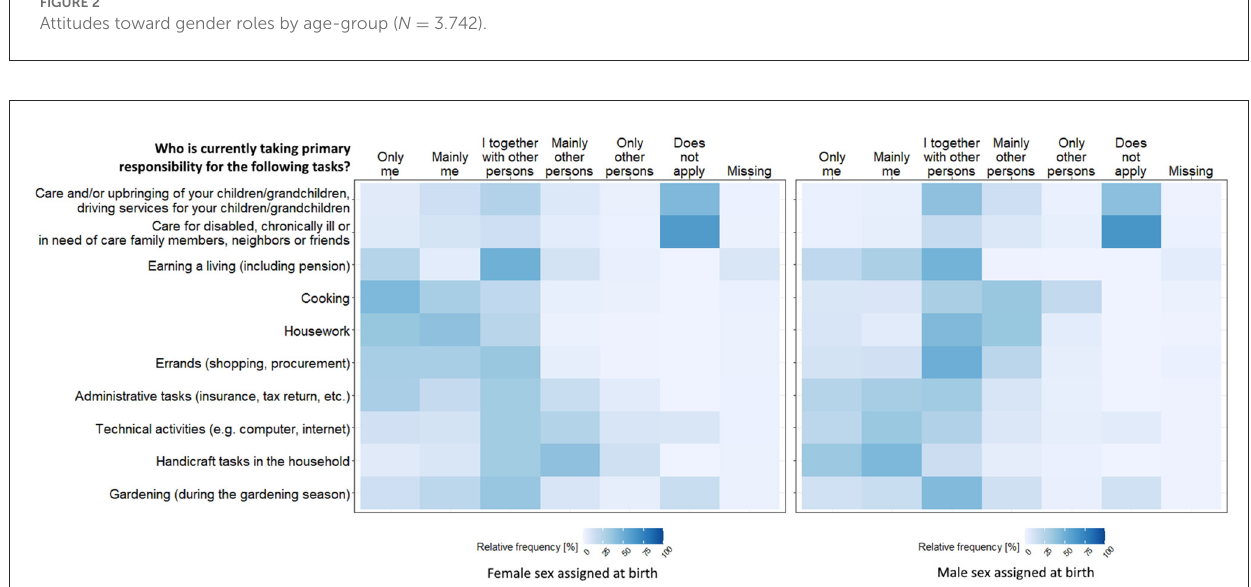
FIGURE3 Relative frequencies of responsibilities for care and household activities, separately for female and male sex assigned at birth ( N = 3.742).